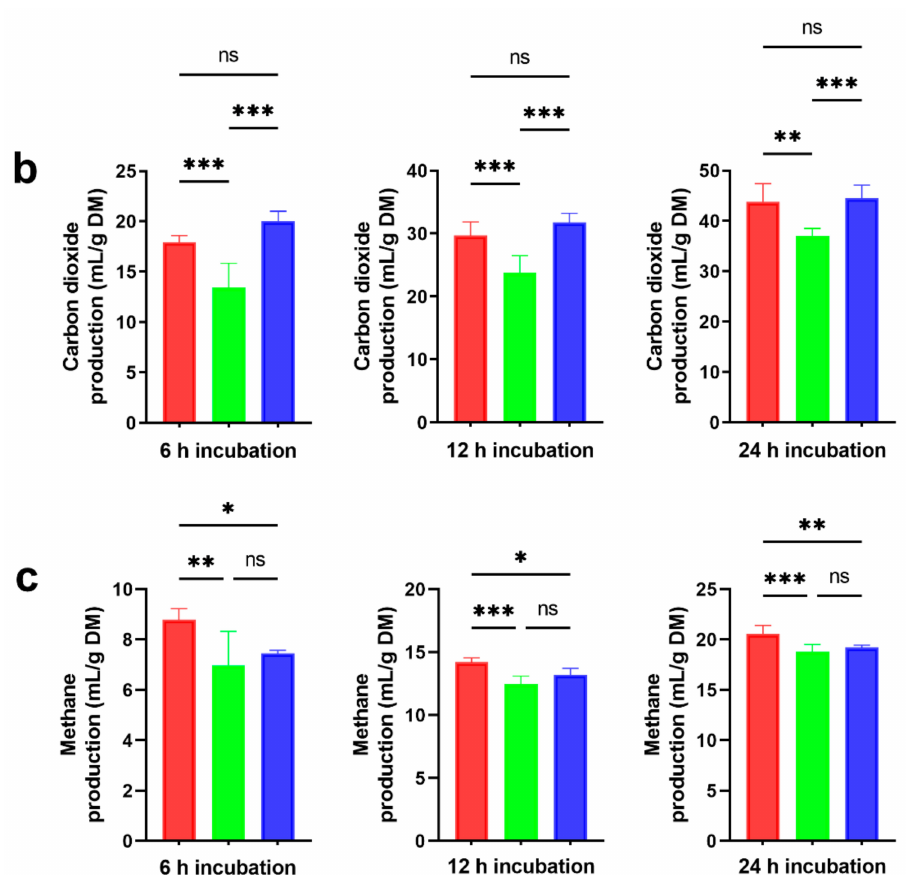
Figure 2. Ruminal gas production of anthocyanin-rich black cane, in both pre-ensiled materials (PBC, ) and ensiled forms (NA, ; 4% MS + 0.030% FS, ), at three time points (6, 12, 24 h) during in vitro rumen incubation: ( a ) total gas production; ( b ) carbon dioxide production; ( c ) methane production. The values shown are the means, with standard errors represented by vertical bars. Significantly different values are indicated as follows: *, p < 0.05; **, p < 0.01; ***, p < 0.001; ns, p >